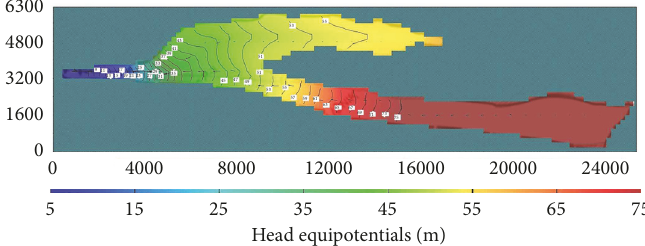
Figure 13: Hydraulic contour lines and the velocity vector in the bottom layer with a thickness of 1m (from − 2 to − 1m a.s.l.) on 15.11.2014, at the onset of the greatest groundwater level for piezometer 𝑃1 position during the simulation period 1.9.2012–05.26.2015.